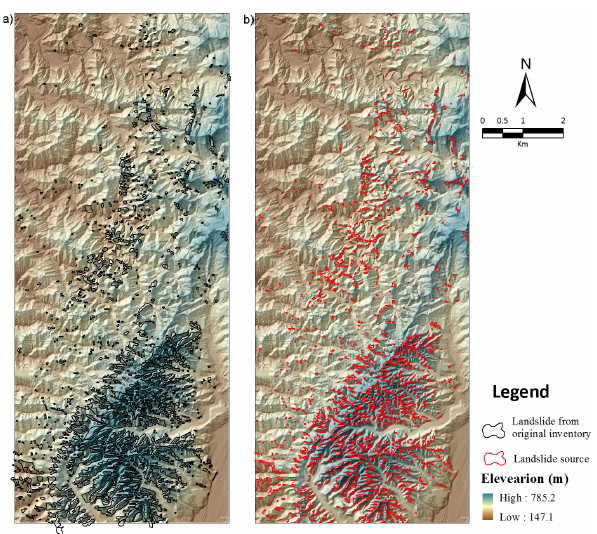
Fig. 3. Terrain map showing the distribution of landslides triggered by the Chi-Chi earthquake in 1999: (a) original inventory, (b) landslide source.